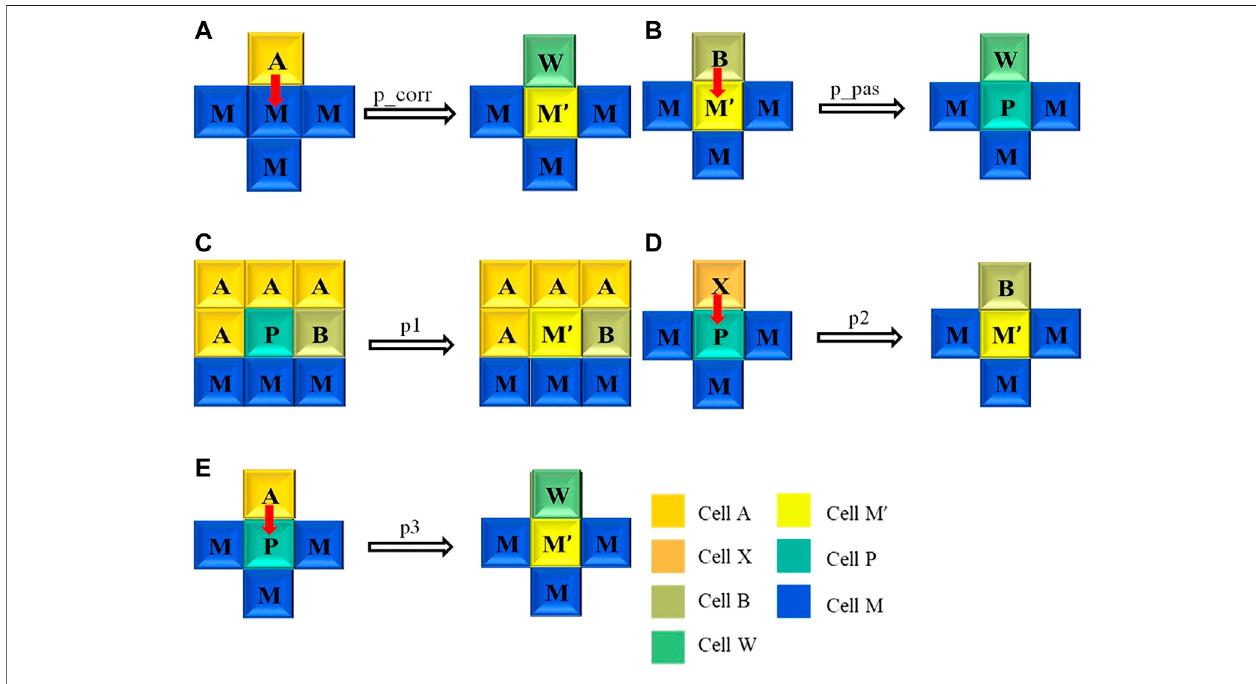
FIGURE 3 | Evolution rules of the cell in a certain step.